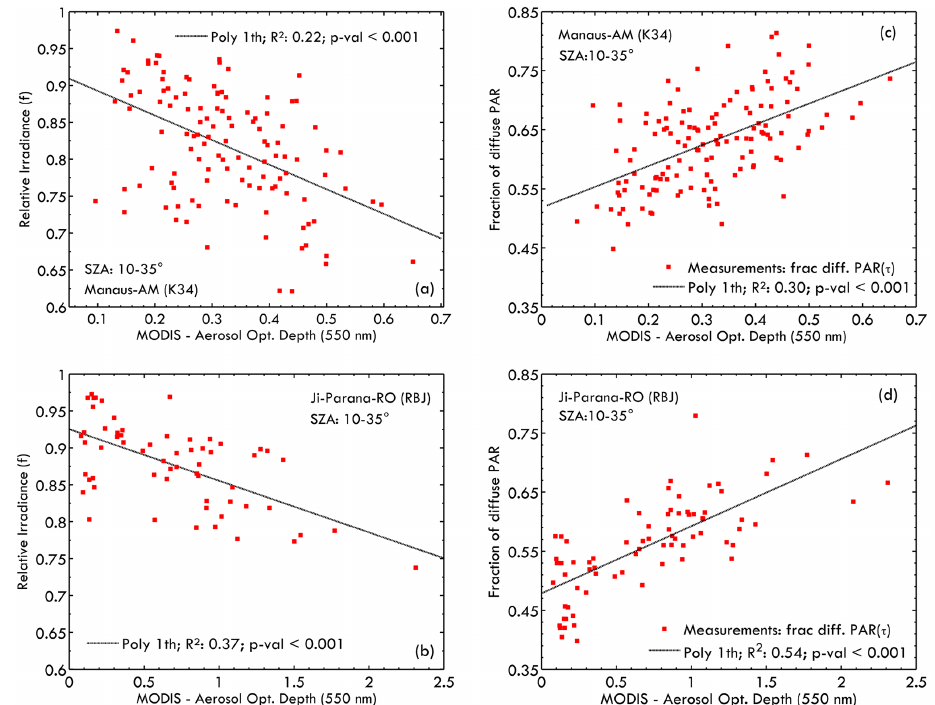
Figure 6. Relationships between relative irradiance f and AOD (MODIS) for Manaus-K34 (a) and Ji-Parana (RBJ) (b) . The lower part shows the fraction of diffuse PAR for K34 (c) (2000–2009) and RBJ (d)